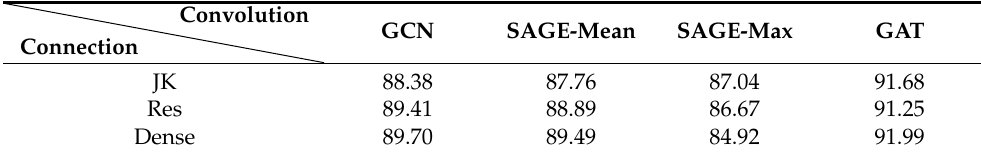
Table 2. Optimal area under the ROC curve (AUC) scores of the 12 models.